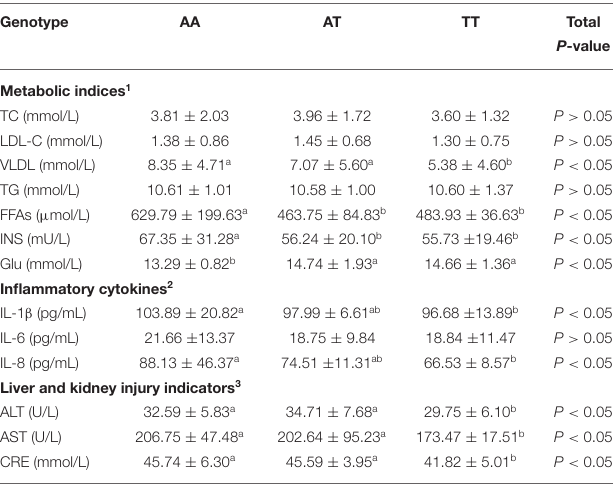
TABLE 1 | Plasma metabolic characteristics of layers with different FMO3 genotypes.